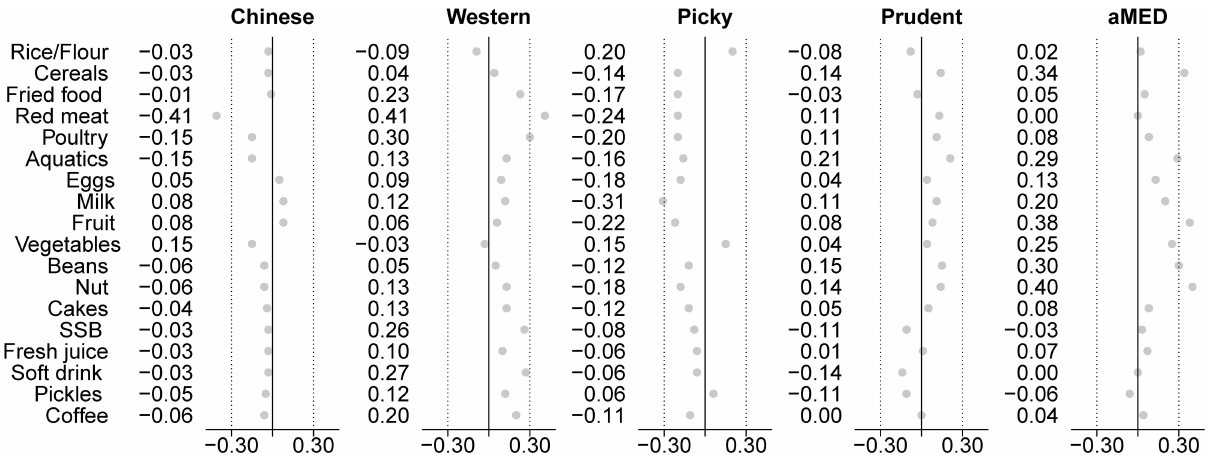
identification of dietary patterns (37). Different